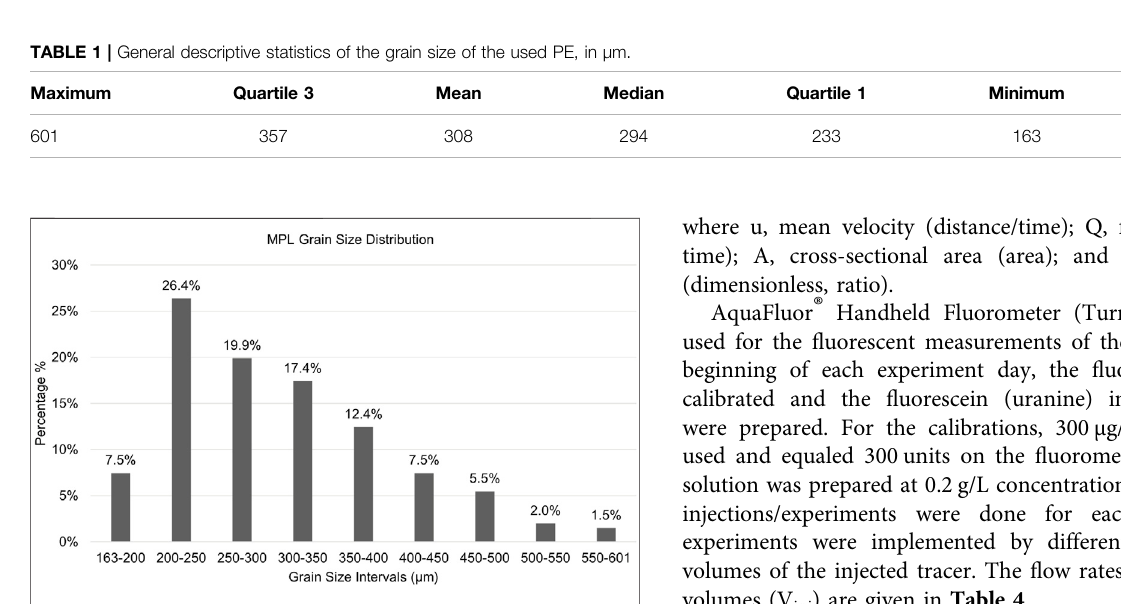
FIGURE 1 | The grain size histogram of the used PE.